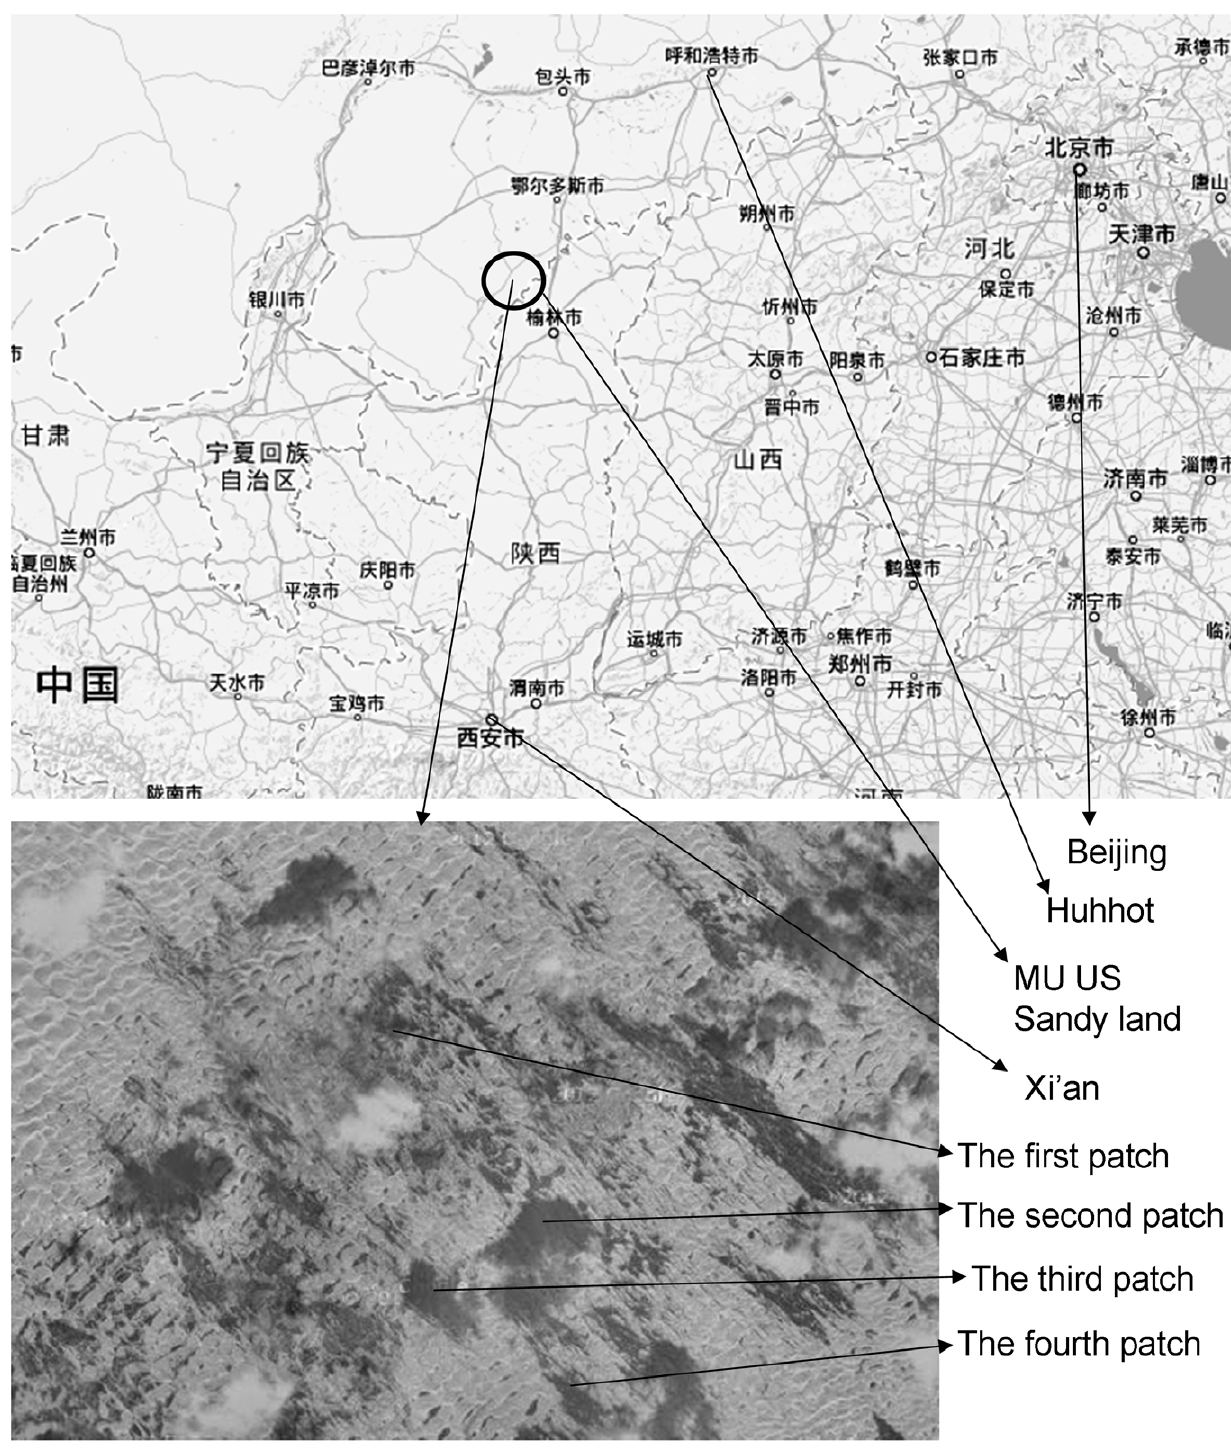
Figure 1. The location of the Mu Us sandy land in northern China. The upper larger map indicates the location of the Mu Us sandy land, and the lower smaller satellite map indicates the four investigated A. ordosica patches, which were surrounded by bare mobile sand. doi:10.1371/journal.pone.0058331.g001 envelopes, shrubs were significantly aggregated [29,32,33]. When shrubs were randomly distributed. In the case of bivariate the actual statistics were below their estimated lower envelopes, analyses, values of O 12 ( r ) above the estimated upper envelopes shrubs were significantly dispersed. Values of the actual statistics indicate that saplings were positively associated with adults between the estimated upper and lower envelopes meant that [29,32,34]. Values of O 12 ( r ) below the estimated lower envelopes